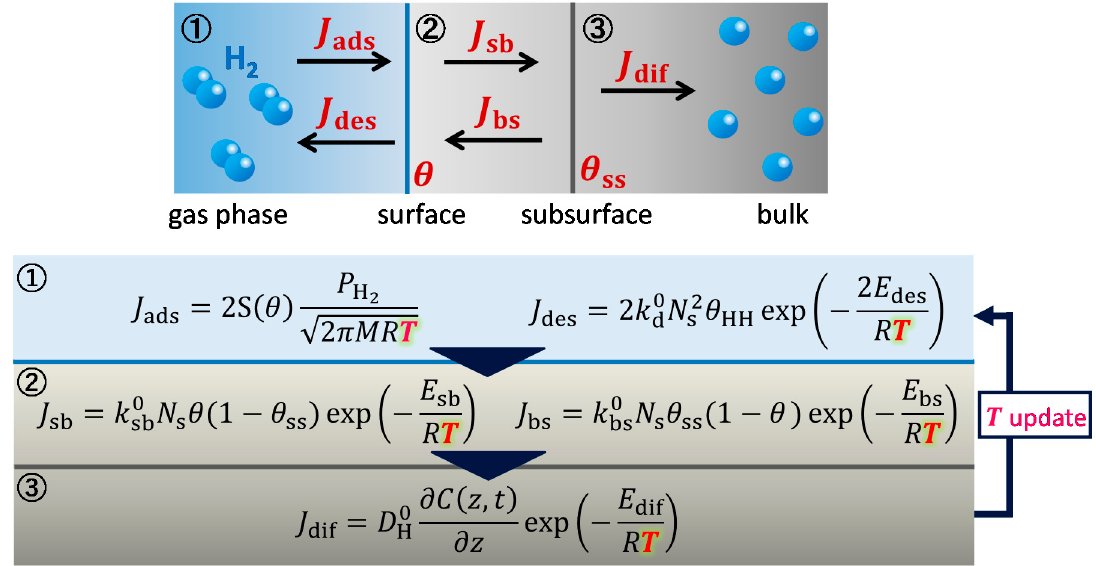
Figure 9. Summary of calculation routine accounting for temperature changes in metals.